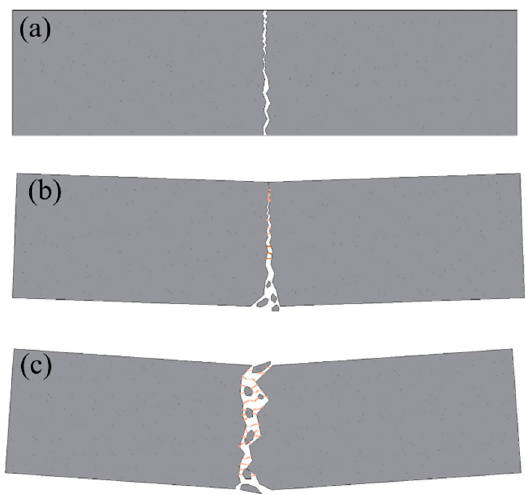
Figure 4. Failure types of specimens: ( a ) type I; ( b ) type II; ( c ) type III.